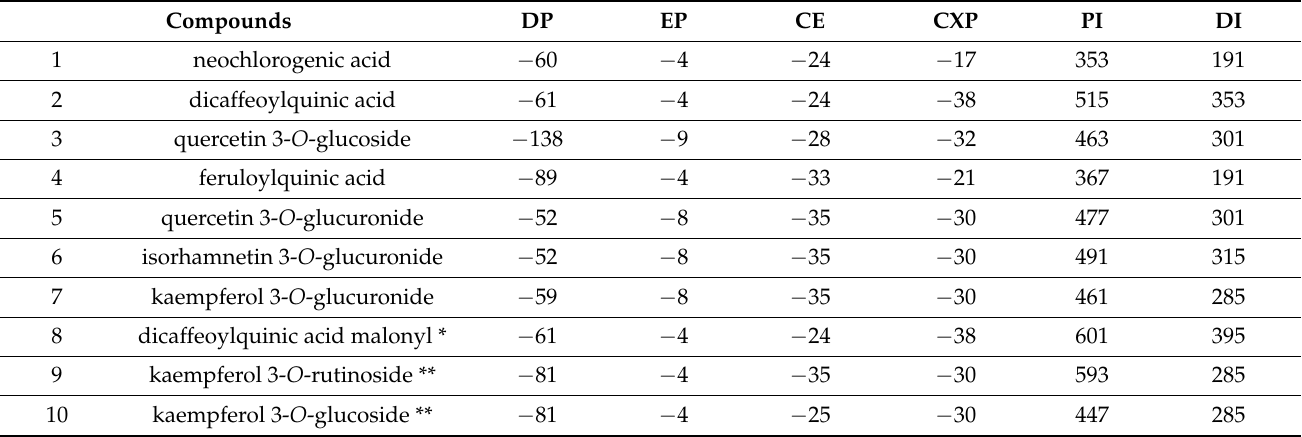
Table 1. Mass spectral parameters and precursor/product MRM transitions of standard compounds measured using a UHPLC system interfaced with an ABSciex Q-Trap 6500 instrument in MRM mode